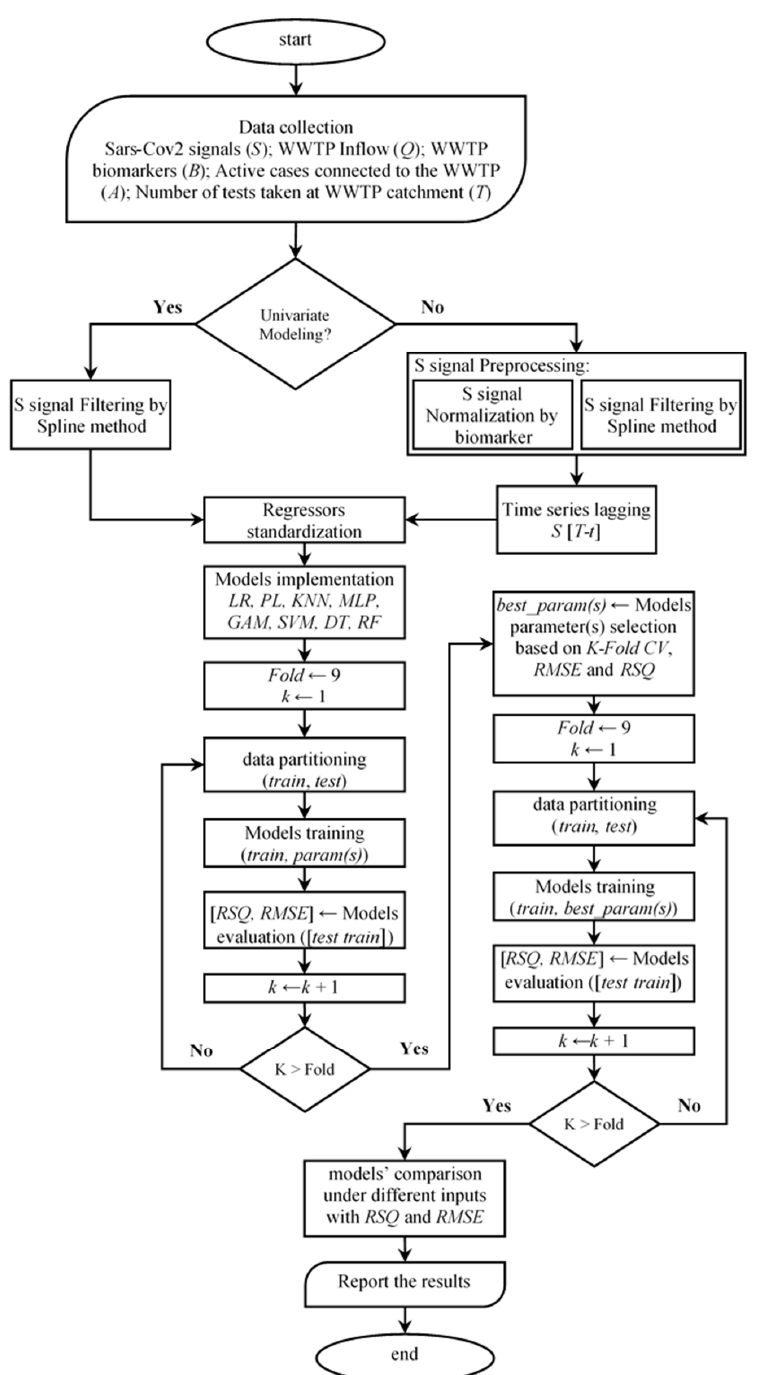
Figure 1. Modelling workflow. Parametric statistical models must be provided with basic parameter information prior to training, for example, the number of neighbours in the K ‐ nearest neighbour method (KNN). To tune these parameters, a range of feasible values was initiated for each method investigated. Next, for each (parameter) option, a k ‐ fold cross validation [48] is performed to assess the model performance, where the regressors are shuffled and split